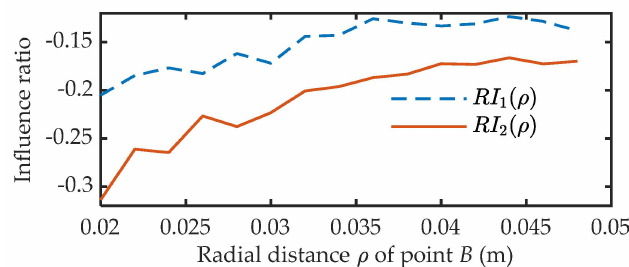
Figure 24. Influence of friction fluctuation in configuration I.